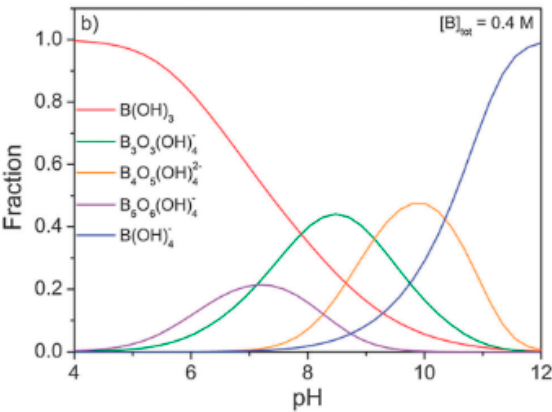
Figure 7. Distribution of boron species as a function of the solution pH (total boron concentration 0.4 M), taken from [101].